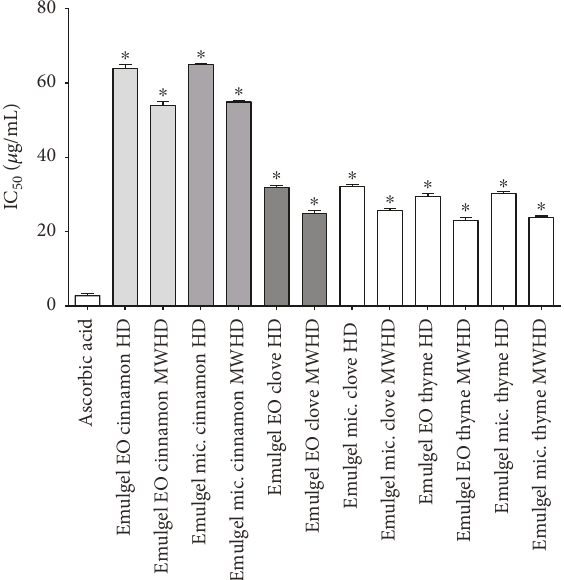
Figure 17: IC of the EO without and with microcapsule emulgels 50 evaluated by the ABTS method. ∗ Signi fi cant di ff erences compared to positive control p > 0 05 .